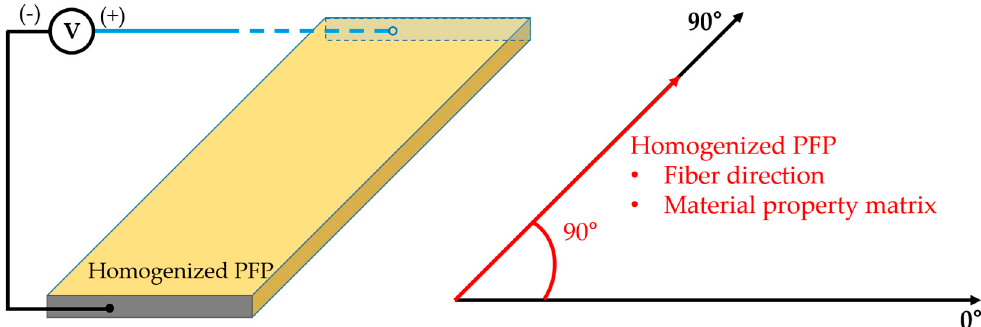
orientation of the material property matrix (piezoelectric, dielectric, and stiffness coefficients) of the homogenized PFP. Table 1. The effective material properties of the homogenized M8557P1 PFP [31]: Young’s modulus ( E ), shear modulus ( G ), Poisson’s ratio ( 𝛾 ), piezoelectric coupling coefficients ( 𝑑 𝑖𝑗 ), and relative permittivity at constant strain ( 𝜀 (cid:3036)(cid:3037) 𝑠 ).